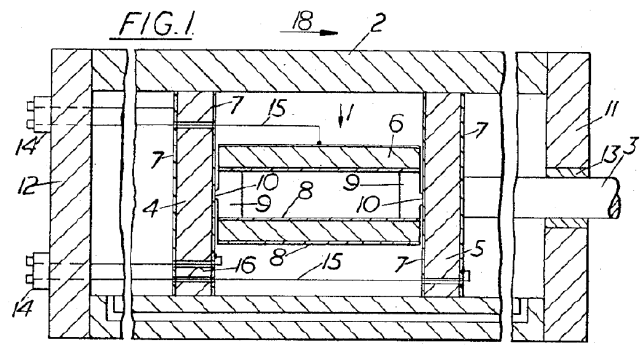
Figure 16. A piezo walk-drive mechanism uses clamping and moving principal, proposed by Brisbane in 1965 [71].